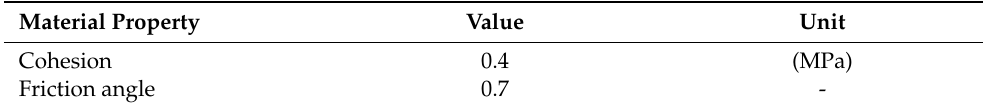
Table 5. Sliding behaviour of masonry walls.